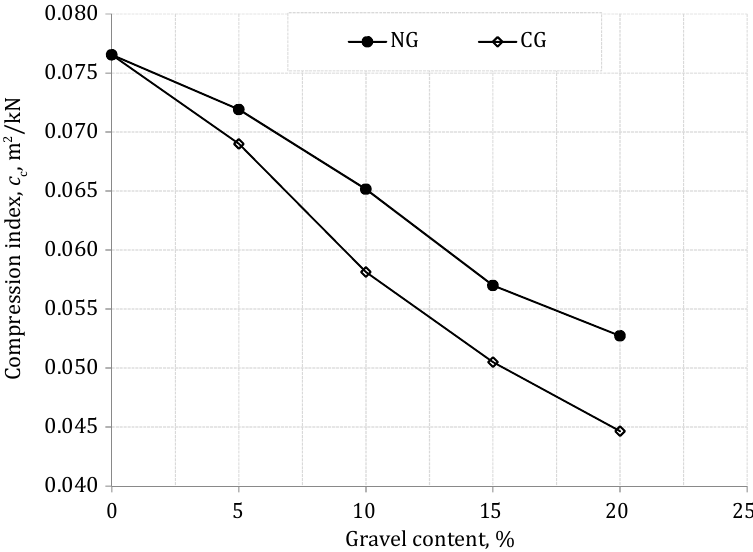
Figure 11. Variation of c c in the clay with NG and